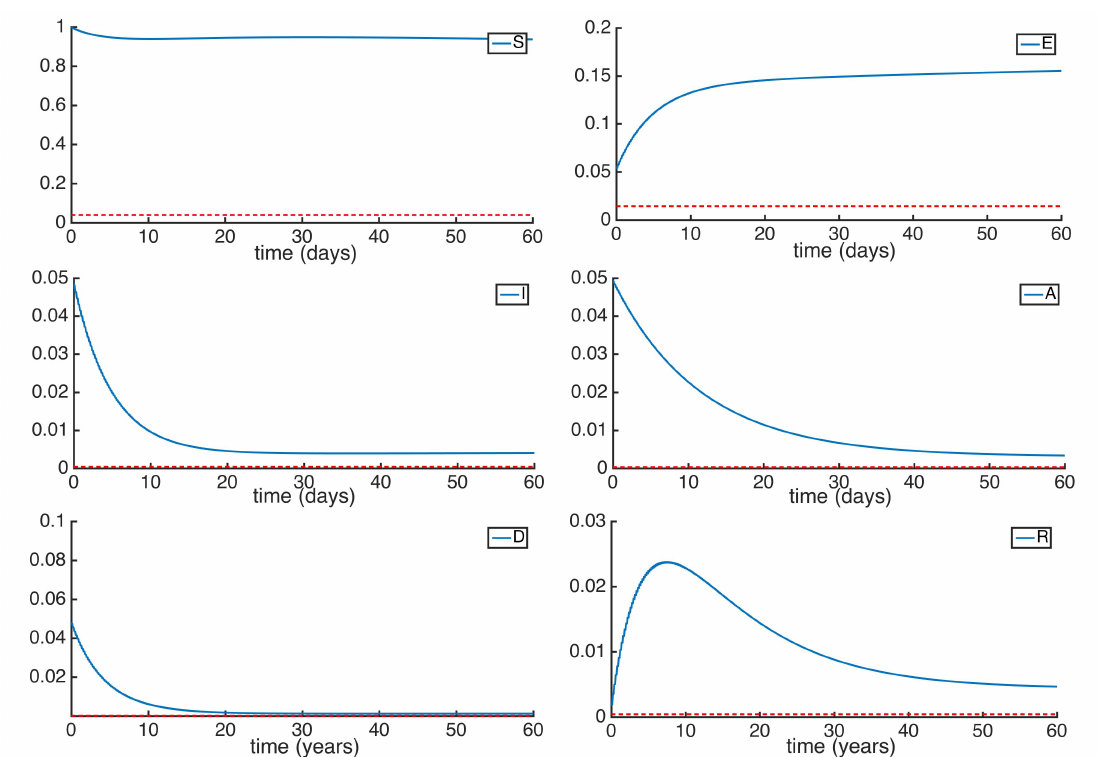
Figure 5. A close look at the beginning of the dynamic simulation of the different subpopulations for a R 0 =